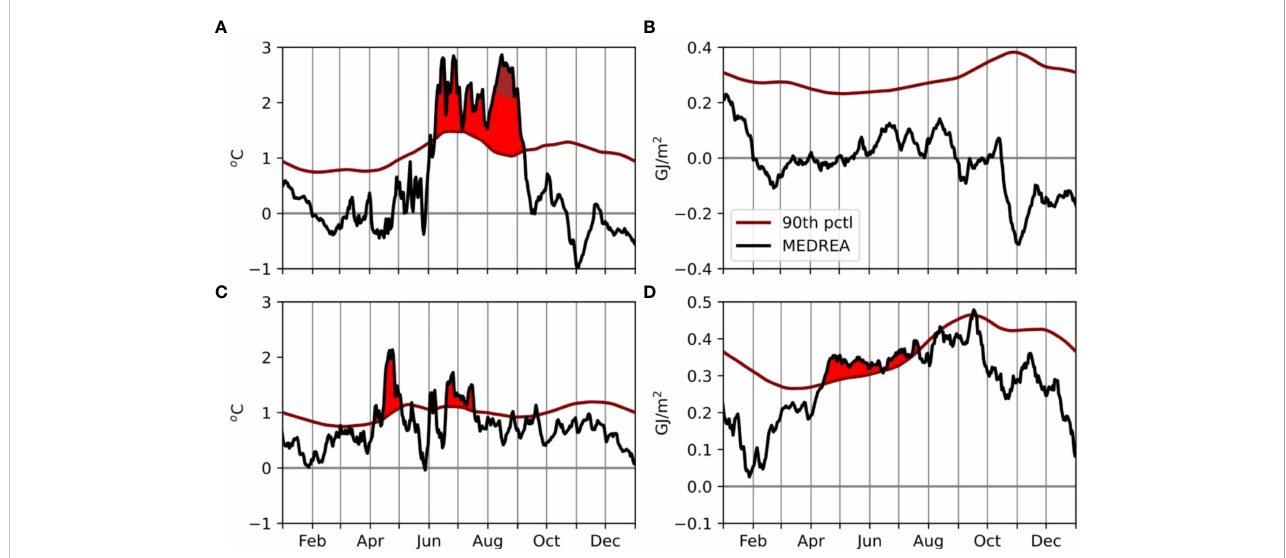
FIGURE 11 Time series of daily SST and OHC[0-100 m] anomalies. (A, B) show the 2003 time series for the Spain-Middle (ES-M) EEZ, while (C, D) show the 2016 time series for the Egypt (EG) EEZ. The 90th percentile threshold is shown by the red line. Shading indicates when MHWs were detected, colored according to their categories as de fi ned by Hobday et al. (2018): red (dark red) shading indicates when the MHW is moderate ( strong